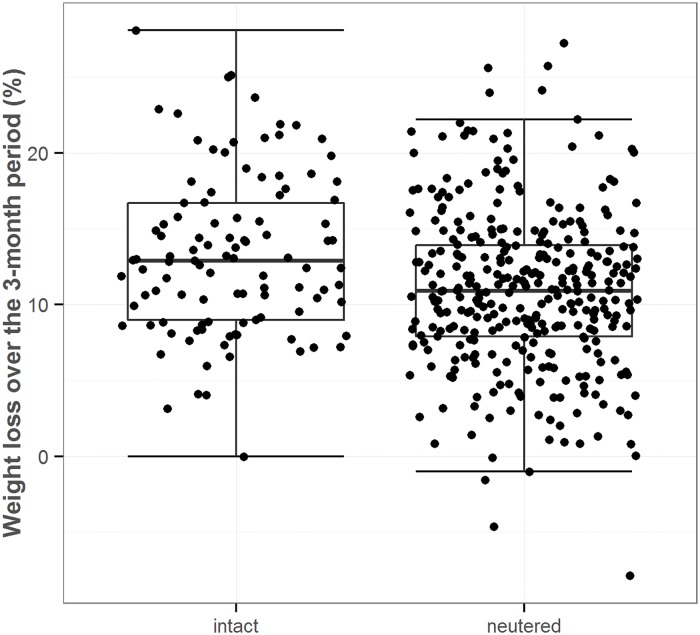
Box-and-whisker dot plots comparing percentage weight loss in intact and neutered dogs over the 3-month study.The boxes depict median (horizontal line) and inter-quartile range (top and bottom of box), the vertical lines depict 1.5 times the inter-quartile range, and individual dogs are shown by the black circles.